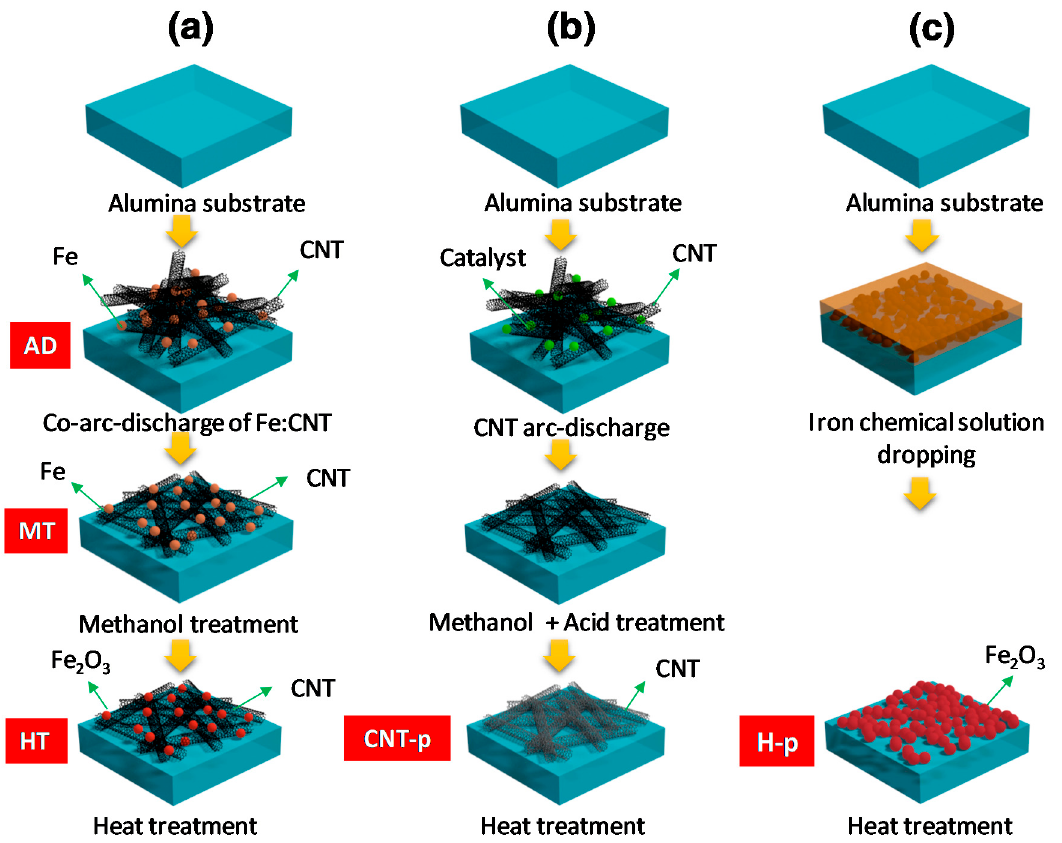
Figure 1. Experimental procedure of fabricating the ( a ) as-deposited (AD) and methanol-treated (MT) iron:carbon nanotubes (Fe:CNT) and heat-treated (HT) hematite (Fe 2 O 3 ):CNT composite structures, ( b ) pure CNT, and ( c ) pure Fe 2 O 3 .